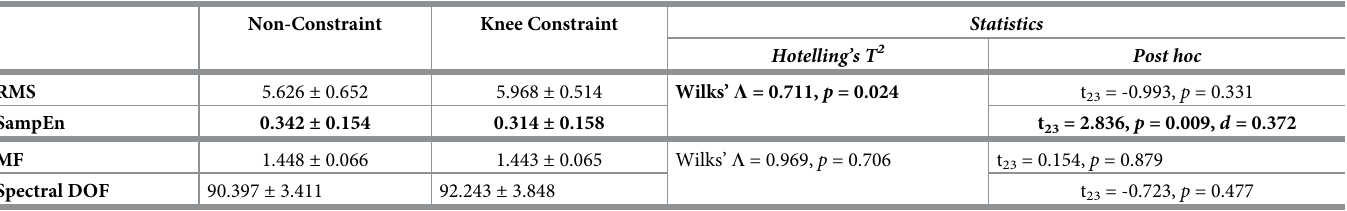
Table 1. The contrast of stabilometer angular velocity variables in the temporal (RMS and SampEn) and spectral (MF and spectral DOF) domains between the non- constraint (NC) and knee constraint (KC)